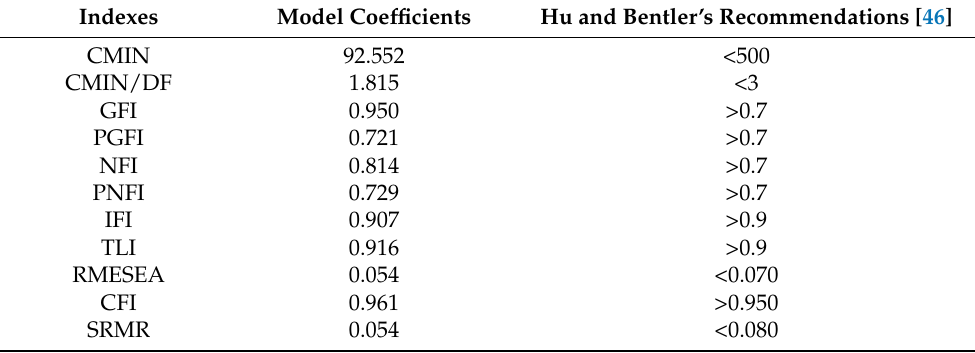
Table 1. Coefficients of the AFC model and recommended values.